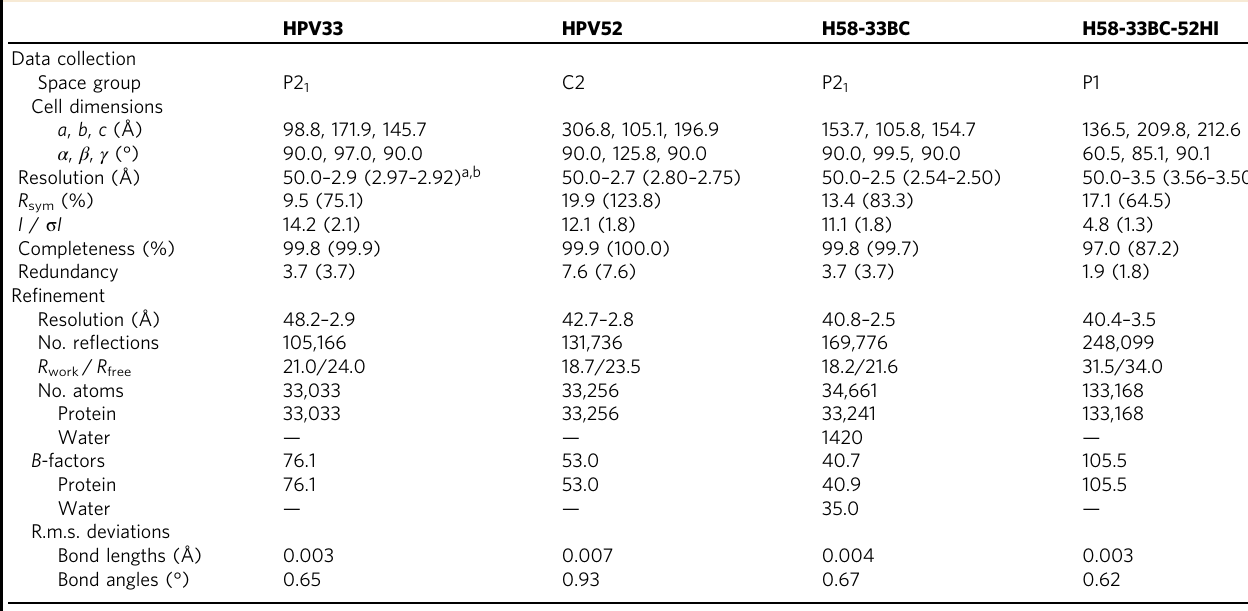
Table 1 Data collection and re fi nement